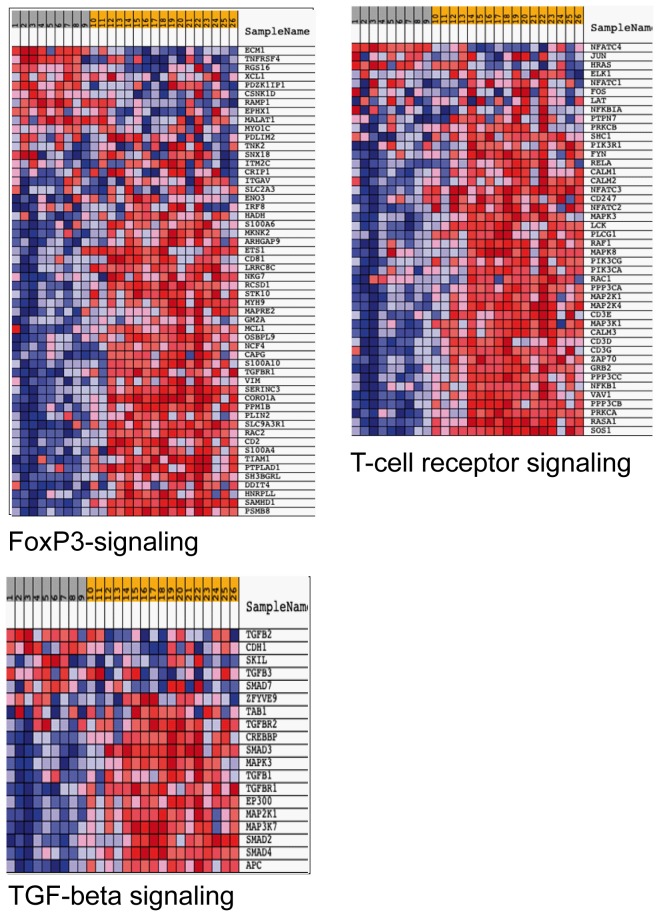
Comparison of gene expression of PBLs of mRCC patients and healthy controls following normalization of microarray expression data. Gene Set Enrichment Analysis (GSEA) was performed for 17 mRCC patients PRE (yellow background, #10–26) vs. 9 healthy controls (grey background, #1–9).GSEA uses a Kolmogorov Smirnov statistic to explore unique gene signature of small groups of genes within a data set. Shown are representative pathways that were up-regulated in the mRCC samples (p<0.05).